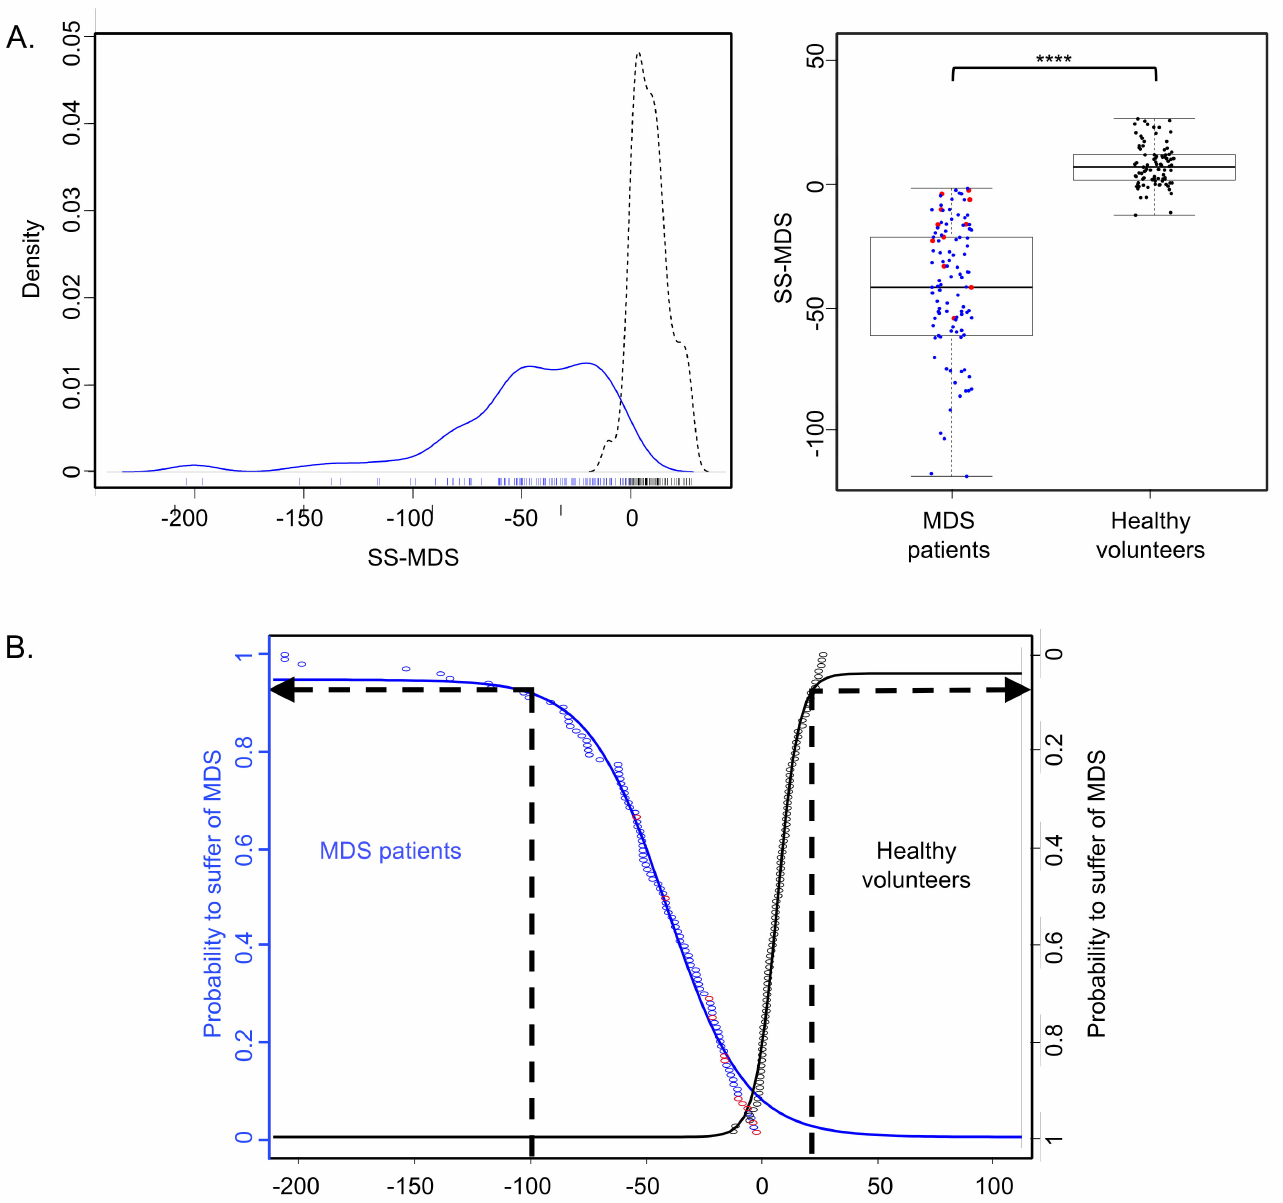
Figure 4. MDS likelihood score (MDS-LS) of MDS patients (blue) and healthy volunteers (black). In red, the 11 MDS patients for whom the MDS-LS would have been decisional to trigger a blood smear (no blood smear with the classical procedure). ( A ) MDS-LS density (left panel) or boxplots (right panel) of MDS patients and healthy volunteers. The outliers are not shown in the boxplot representation. MDS-LS of both cohorts are significantly different (****: p < 0.0001). ( B ) Empirical cumulative distribution function. The vertical axis represents the probability to suffer from MDS. If the MDS-LS is negative, there is an increasing probability of MDS, justifying blood smear. For example, if the MDS-LS value is − 100, this probability is